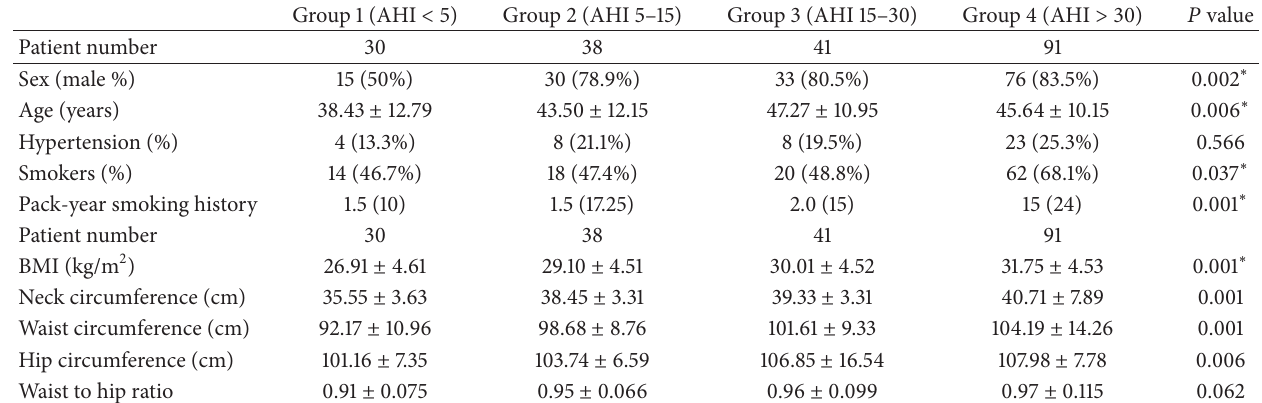
Table 1: Demographic and anthropometric characteristics of the patients.